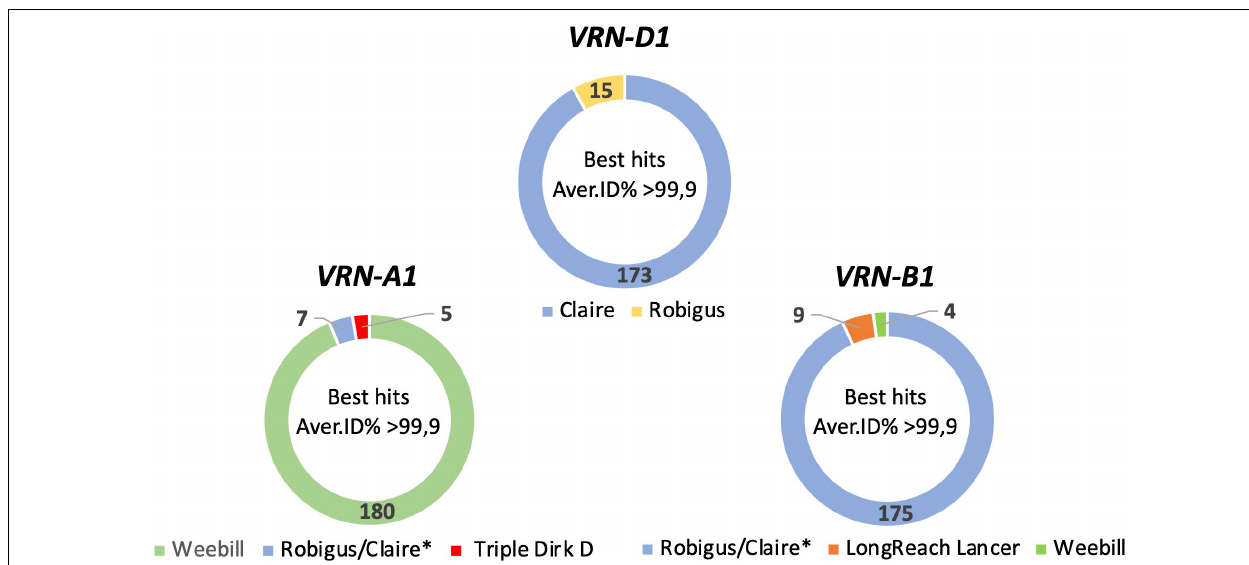
FIGURE 1 | Pie graphs showing the classification for full-length VRN1 sequences from 192 wheat cultivars based on the result of top BLASTn hits against a VRN1 reference database (average > 99.9% identity). The numbers represent the number of cultivars in each group. ∗ The VRN-A1 and VRN-B1 sequences are identical in references genomes Claire and Robigus. The VRN-D1 sequences are different in reference genomes Claire and